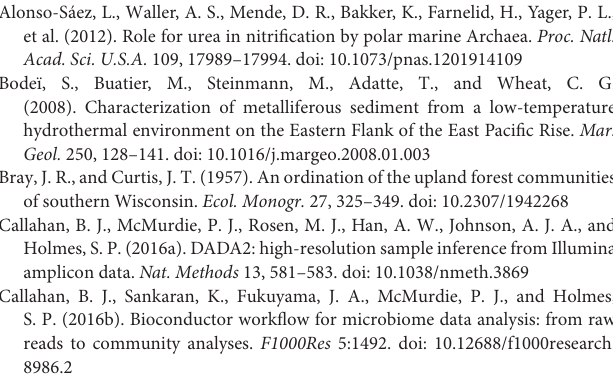
FIGURE S4 | Class level assignments of major groups in sediments on Dorado Outcrop, based on averages of triplicate samples. Thaumarchaea, Planctomycetes, and Proteobacteria classes dominate in the hydrothermal samples. FIGURE S5 | Relative abundances of genera at Dorado Outcrop. The x -axis includes all samples, with each replicate individually shown. The y -axis shows all assigned genera over 0.15% abundance. Candidatus Scalindua and Candidatus Nitrosopumilus are abundant in hydrothermal samples. FIGURE S6 | Violin plots of percentages of specific taxa separated by sample type (B, background; I, intermediate; H, hydrothermal) and depth (color coded as blue for 3–4 cmbsf and black for 9–10 cmbsf). On the y -axis, the violin plots display the distribution of relative percentages of the selected taxa in each sample type. (a–f) Shows taxa whose relative percentages were increased in hydrothermal sediments, relative to background or intermediate samples. (g–l) Shows taxa whose relative percentages were decreased in hydrothermal sediments.